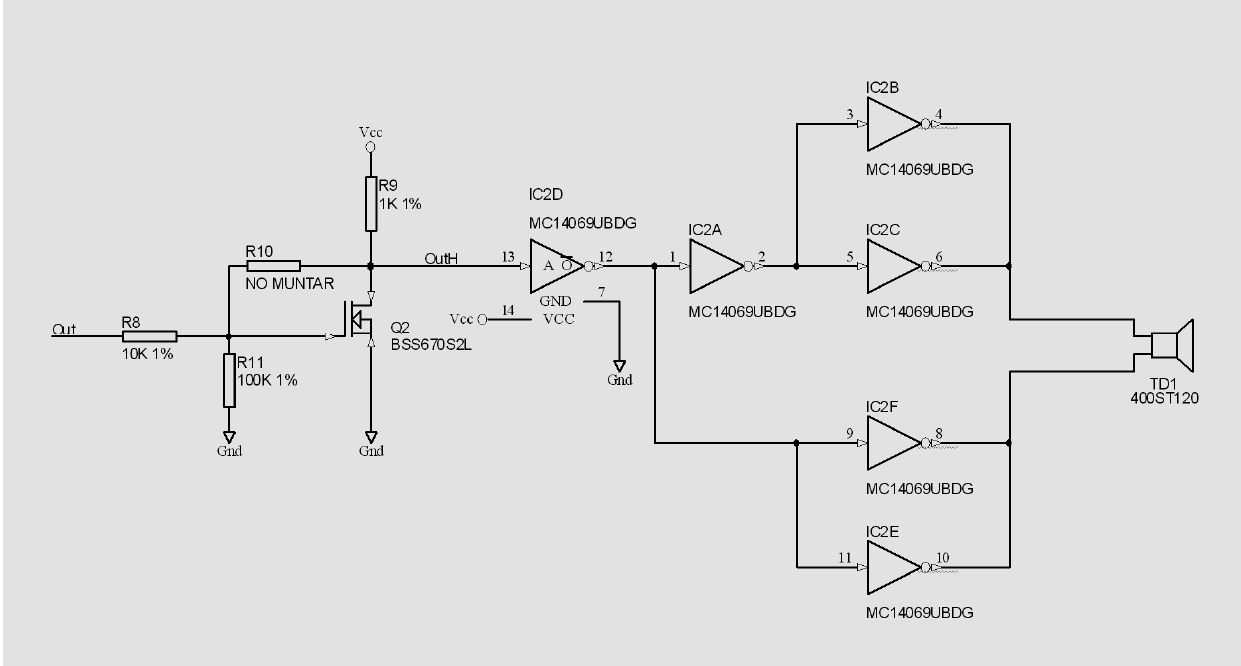
Figure 11 . Ultrasound transducer and